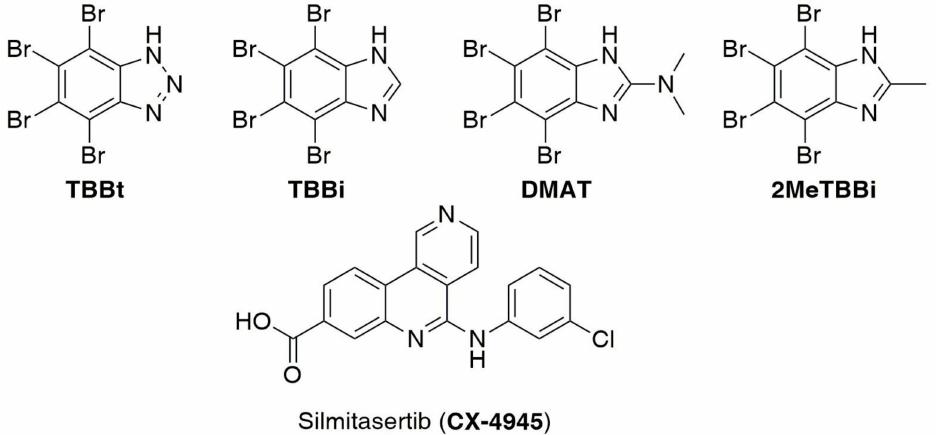
Figure 1. Representative examples of CK2 inhibitors: 4,5,6,7-tetrabromo-1 H -benzotriazole (TBBt), 4,5,6,7-tetrabromo-1 H -benzimidazole (TBBi), 4,5,6,7-tetrabromo- N , N -dimethyl-1 H -benzimidazol- 2-amine (DMAT), 4,5,6,7-tetrabromo-2-methyl-1 H -benzimidazole (2MeTBBi), and silmitasertib